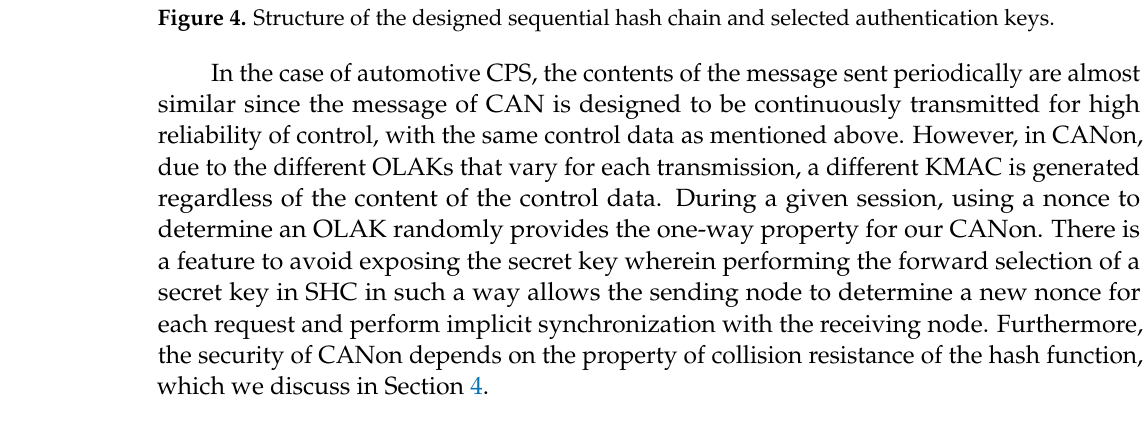
Figure 4. Structure of the designed sequential hash chain and selected authentication keys.